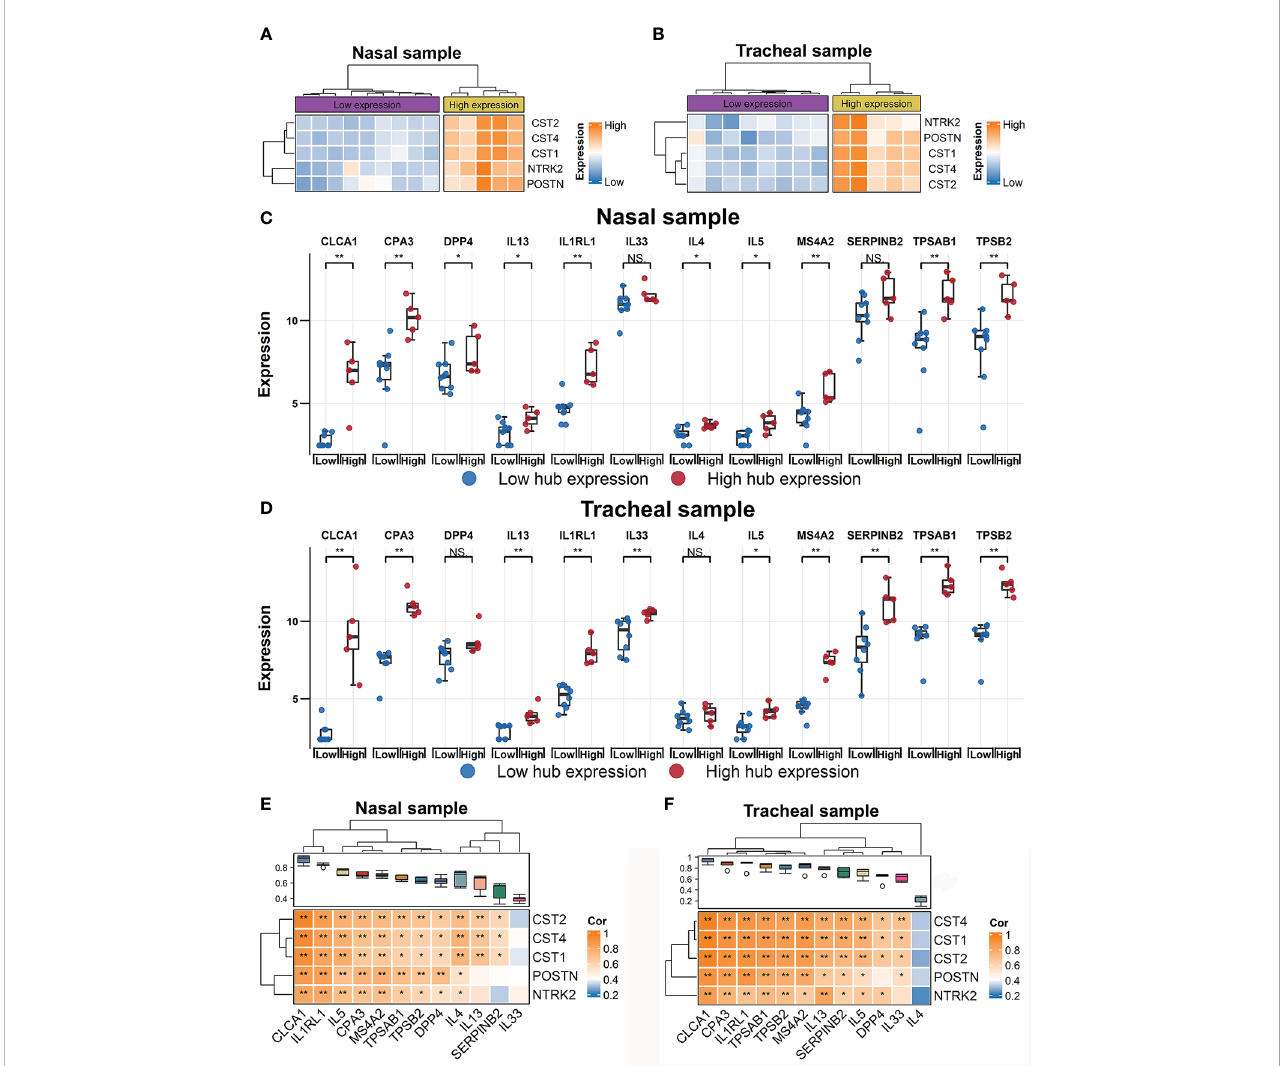
FIGURE 2 Identi fi cation of RW patient subsets using expression pro fi les of hub genes. Heatmap of hierarchical clustering of POSTN, CST1, CST2, CST4, and NTRK2 expression levels across all subjects with RW in nasal (A) and tracheal samples (B) , respectively. Comparison of gene expression levels of 12 T2 in fl ammatory markers between high- and low-hub expression groups of all RW patients across nasal (C) and tracheal samples (D) . Statistical signi fi cance was assessed using Wilcoxon rank-sum test. Asterisks indicate P -values for hub high-expression versus hub low-expression. * P < 0.05, ** P < 0.01. Correlation heatmaps showing associations between hub genes (row) and 12 T2 in fl ammatory markers (column) across nasal (E) and tracheal samples (F) . Boxplot above heatmap showing correlation coef fi cients obtained by Pearson correlation analyses between each T2 in fl ammatory genes and hub genes. Blue to orange gradient coloration implies increased Pearson correlation coef fi cient. Correlation coef fi cients (r) and P -values were obtained by Pearson correlation analysis. * P < 0.05, ** P < 0.01. NS, no signi fi cance; RW, recurrent wheezing; T2, type